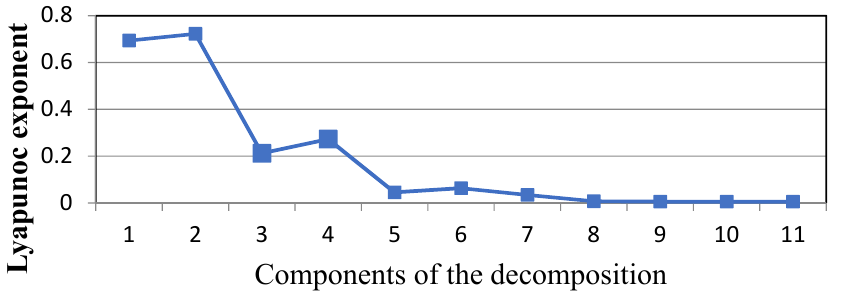
Figure 8. Lyapunov exponent of each level.